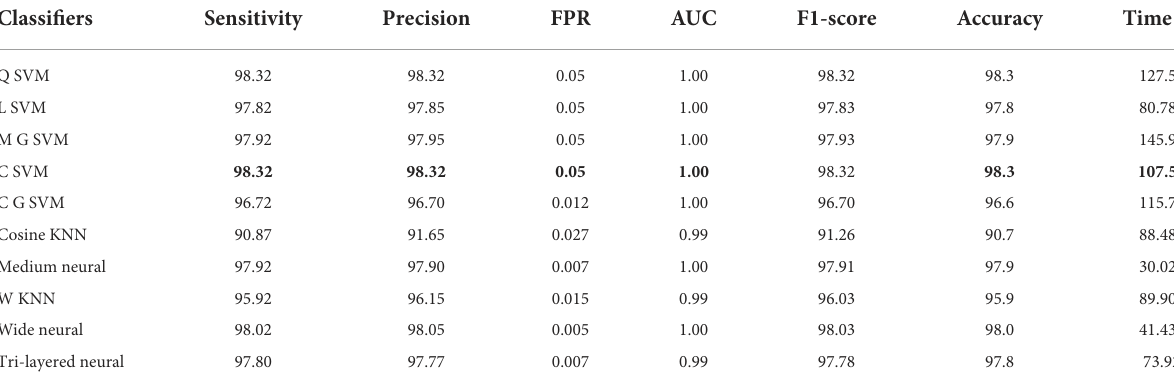
TABLE 6 Proposed features fusion method results on chest X-ray dataset.